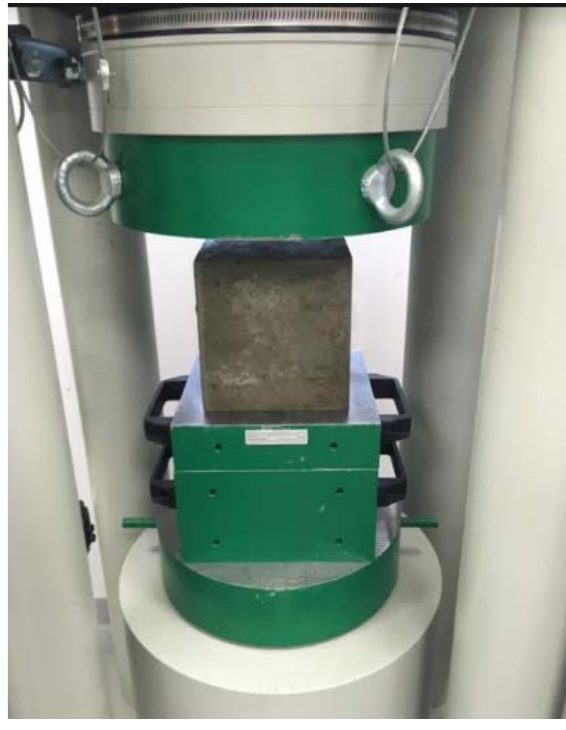
Figure 2. Sample during compressive strength test.